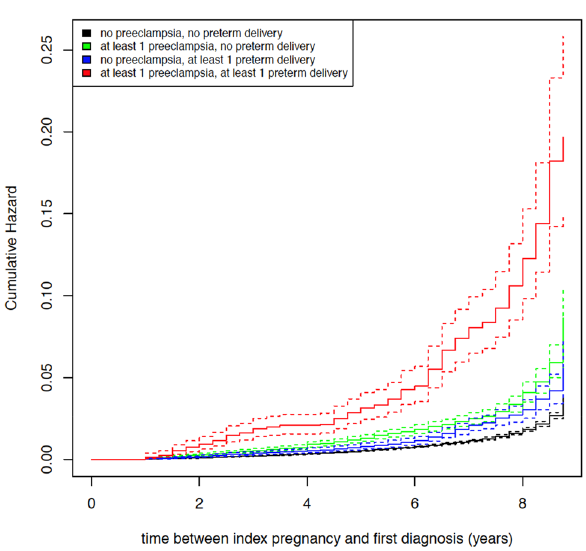
Figure 2. Cumulative hazard plot on risk of mild to moderate subsequent